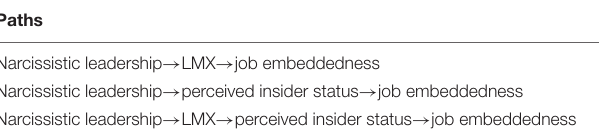
TABLE 4 | Results of bootstrapping mediation effect